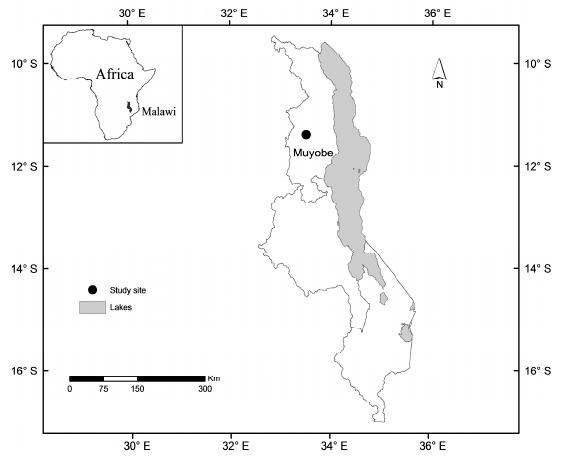
Figure 1. Map of Malawi showing the location of the study site.